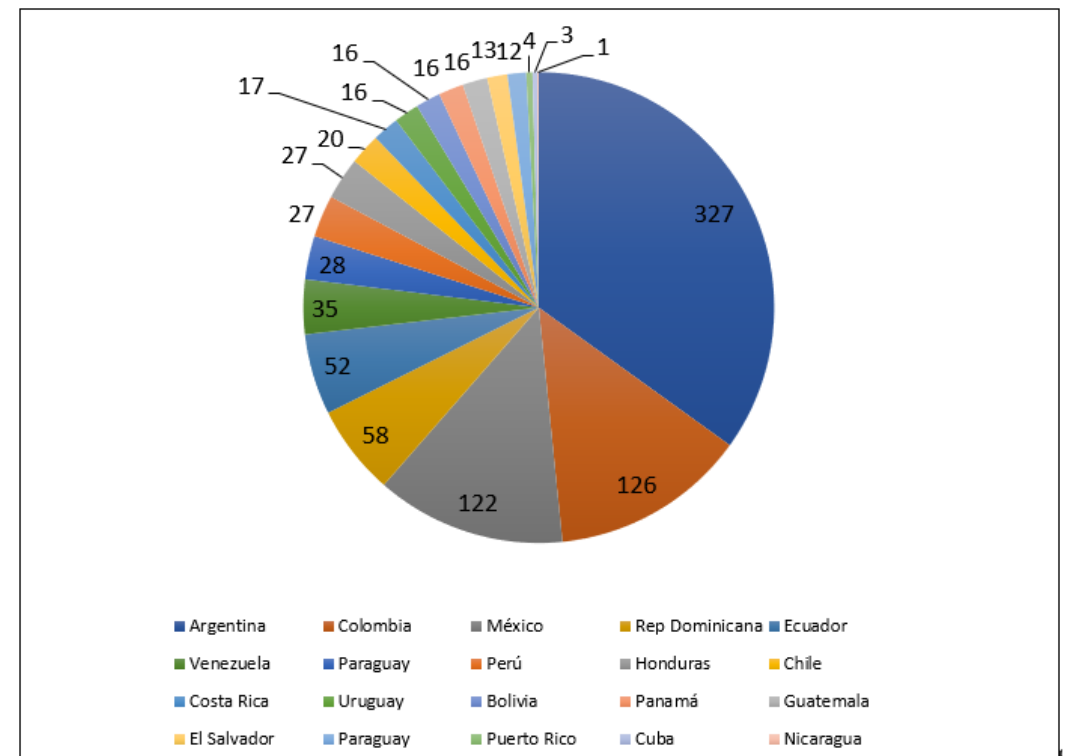
Figure 1. Distribution of participants by geography location.